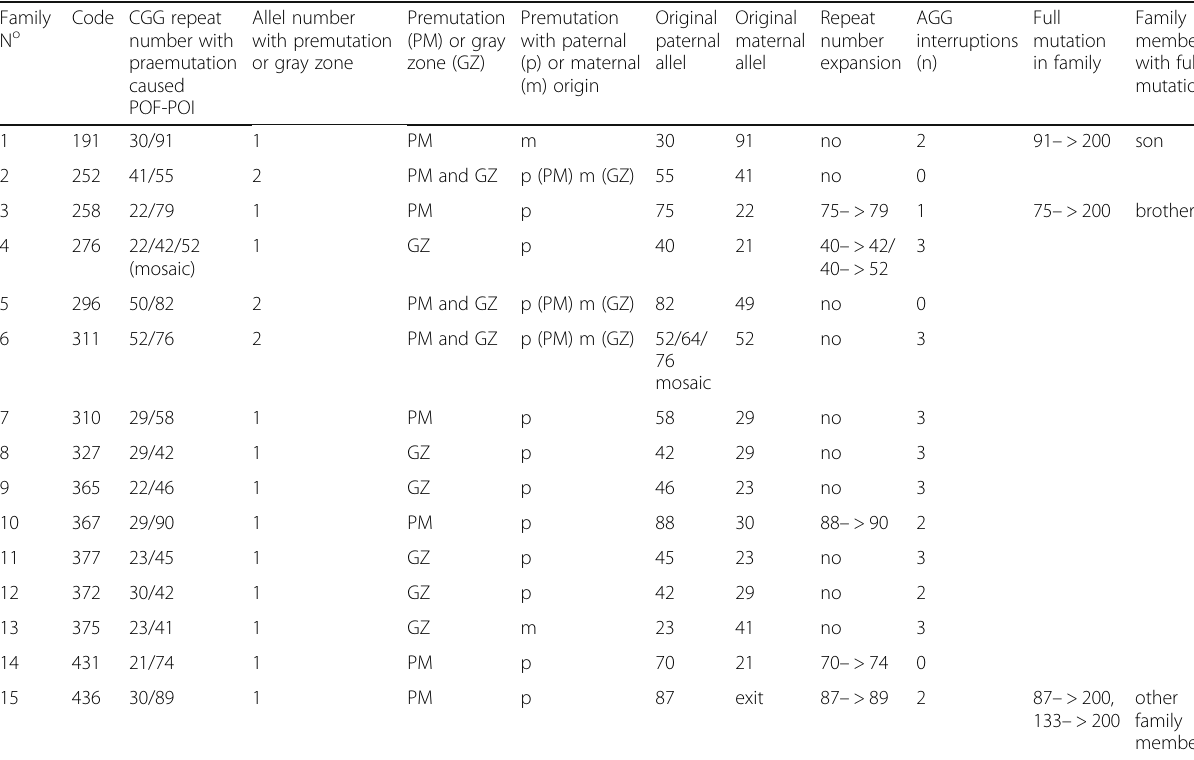
Table 1 In 6 cases the CGG repeat number was within the range 41 – 54 CGG repeat (gray zone), and in 9 cases we found FMR1 premutation (55 – 200 CGG repeat). In 4 cases we found differences in both alleles, one was a premutation allele, and the other allele showed a repeat number belonging to the gray